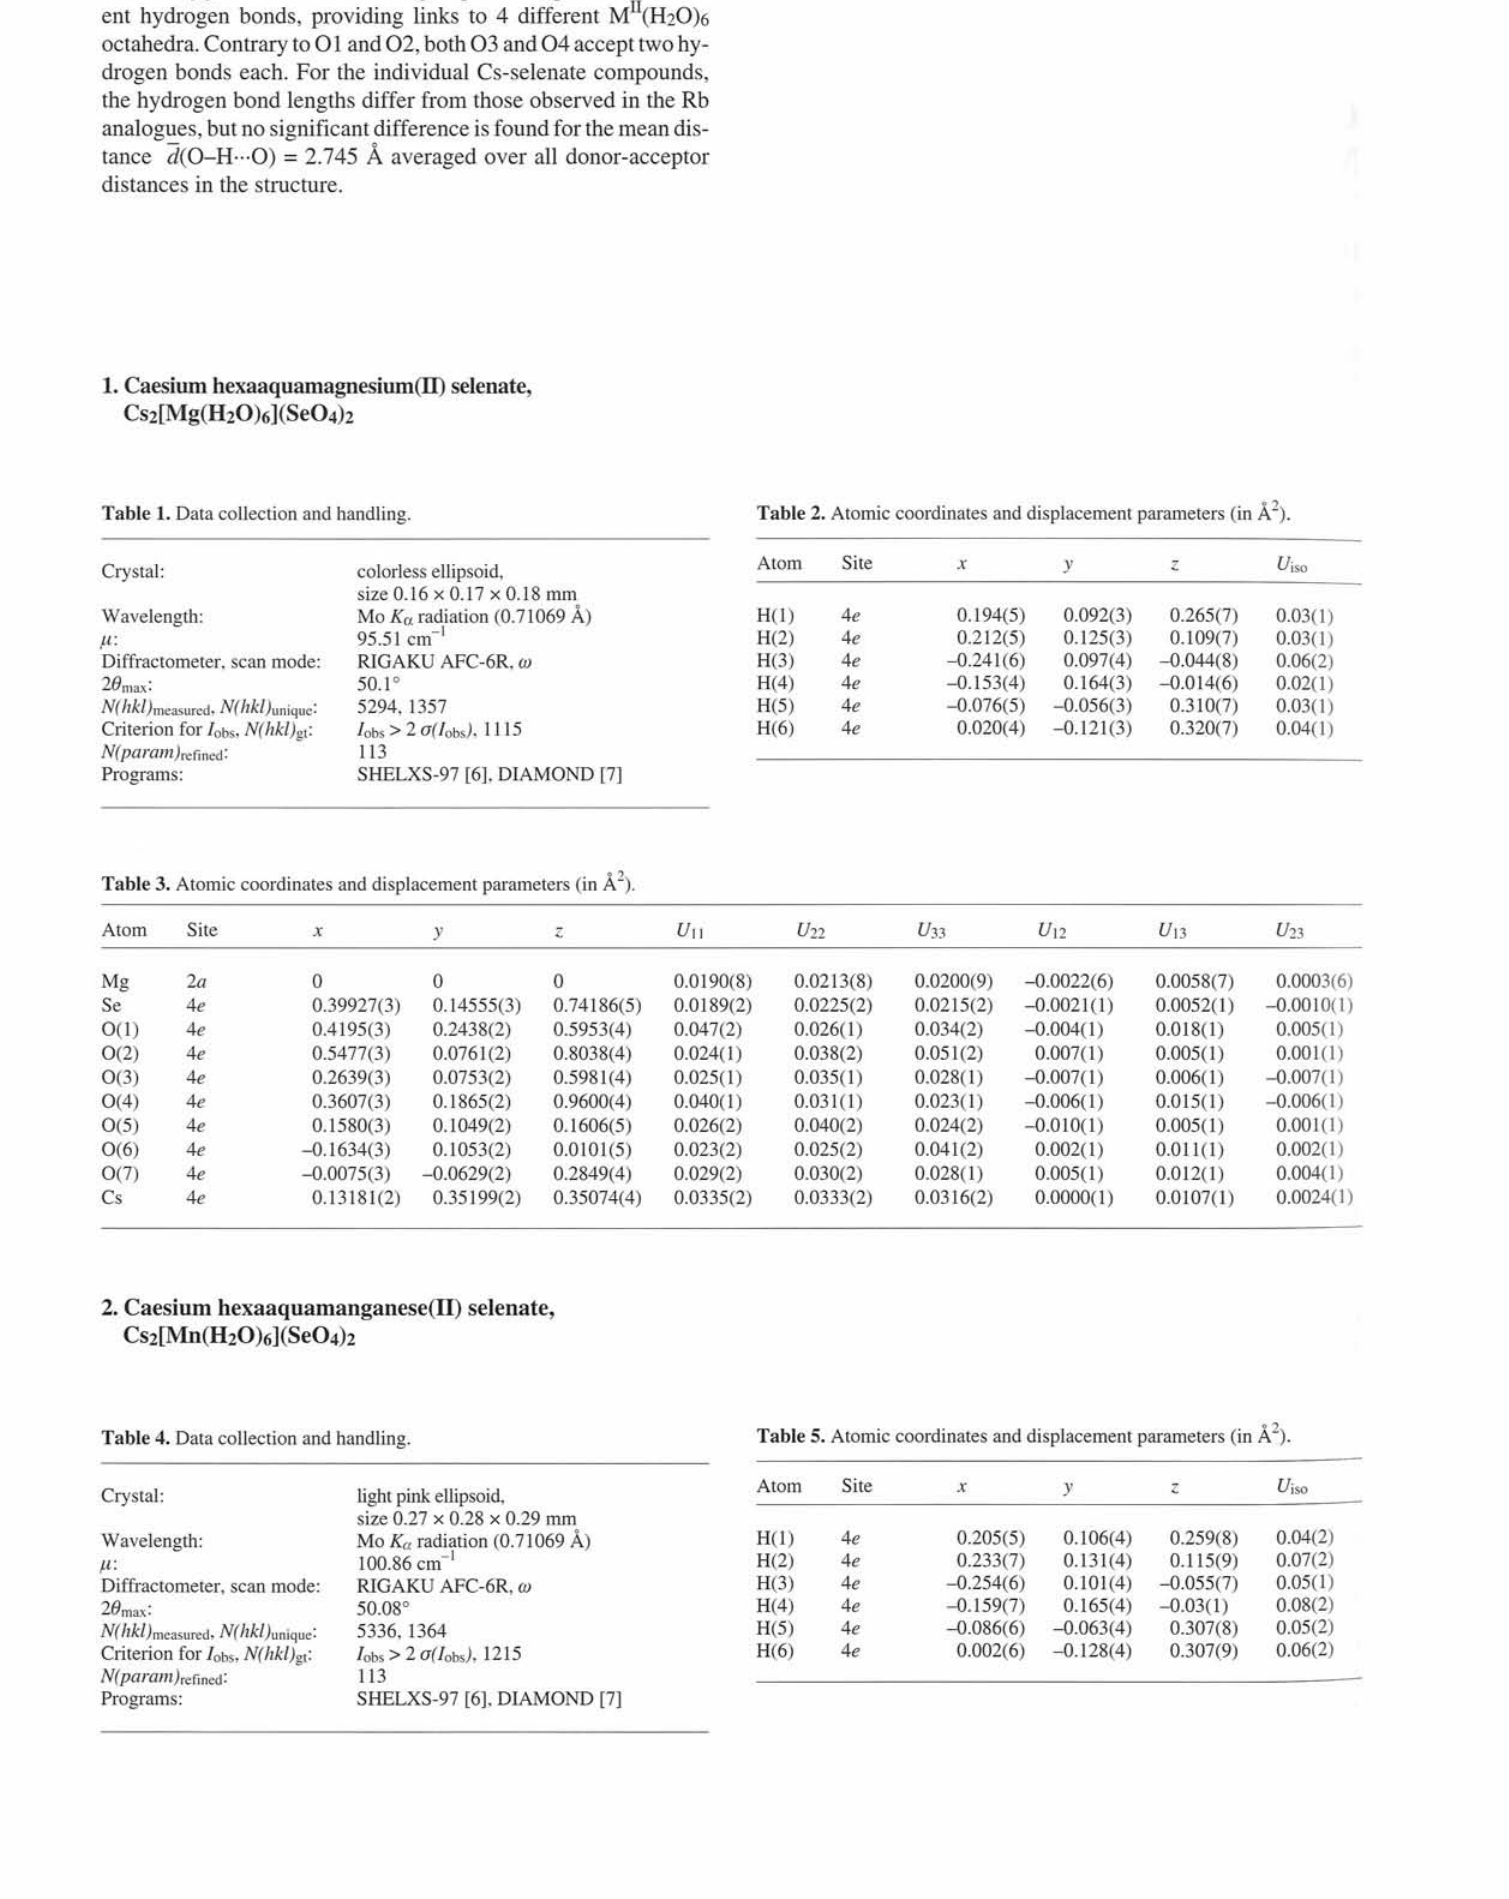
Table 1. Data collection and handling. Table 2. Atomic coordinates and displacement parameters (in A").